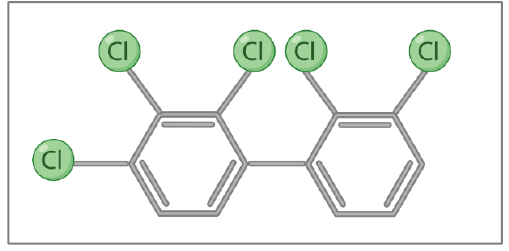
Figure 1. Structure of Arcolor 1254.